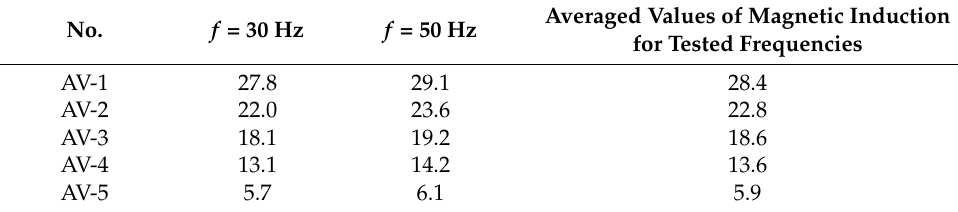
Figure 13. The scheme for calculating the averaged values of magnetic induction (abbreviation AV means ”averaged value”; AV-1 means that the averaged value of magnetic induction was calculated based on the measurements taken in these wells). Differneces in magnetic induction repersented by different colors: the weakest magnetic iduction–dark red; weak magnetic induc- tion–light red; moderate magnetic indcution–light green; the highest magnetic induction–dark green. Table 2. The averaged values of magnetic induction for the tested frequency of RMF. Averaged Values of Magnetic Induction No. f = 30 Hz f = 50 Hz for Tested